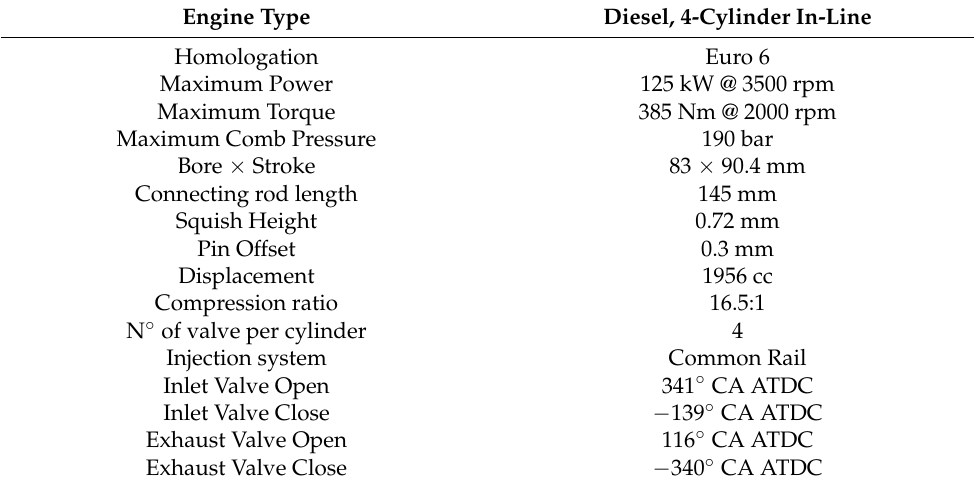
Table 1. Base engine